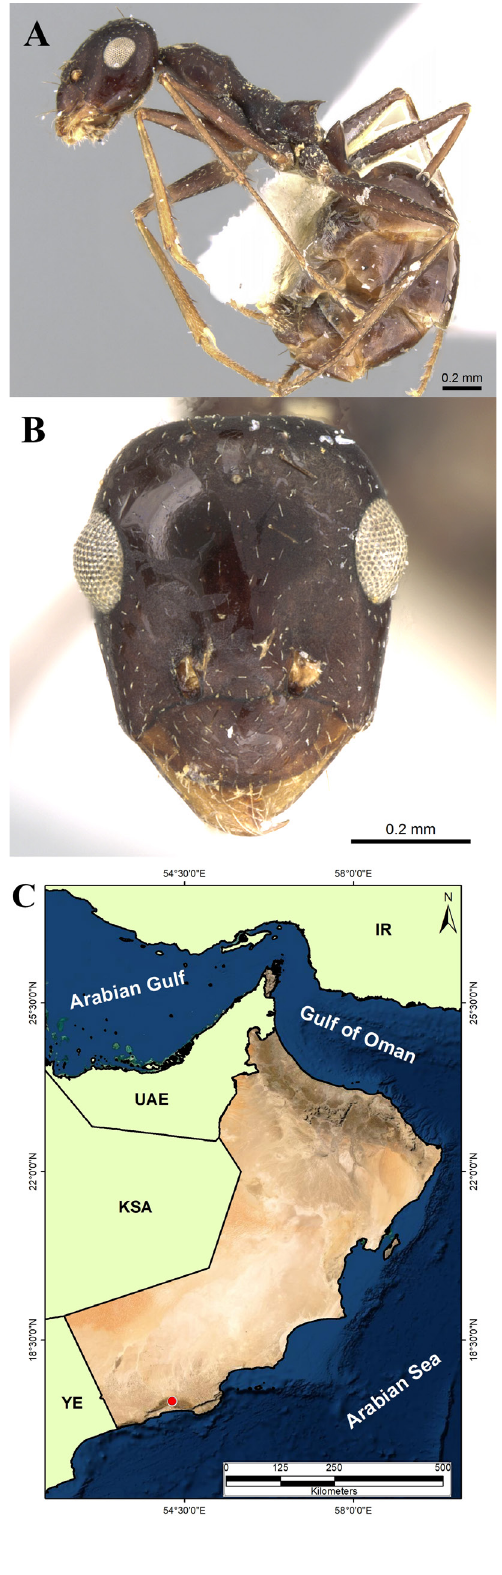
Fig. 17. Lepisiota dhofara Collingwood & Agosti, 1996, paratype, worker (CASENT0906340, AntWeb.org (Estella Ortega)). A . Body in profile. B . Head in full-face view. C . Distribution